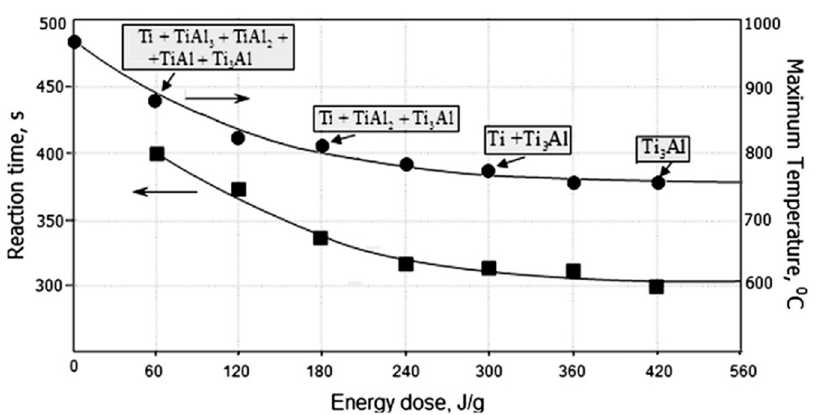
Figure 8. The dependence of the reaction time and T max on the energy dose. The composition of the products of TE is given. Reprinted from [34], Copyright (2012), with permission from Elsevier.